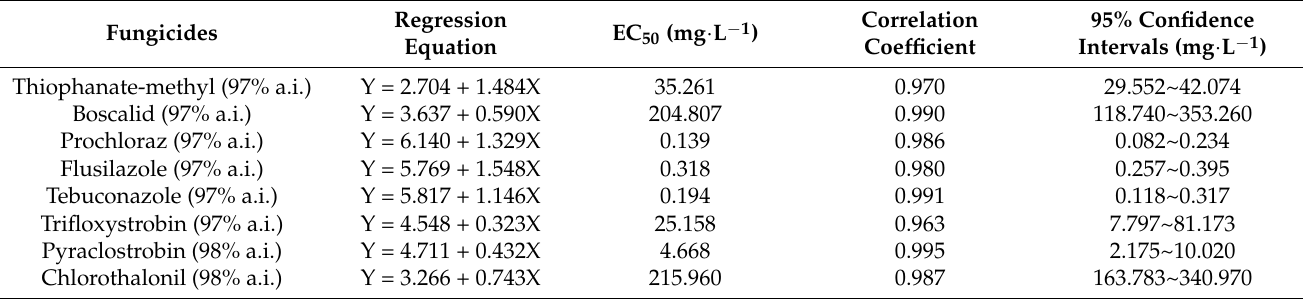
Table 4. Antifungal activities of fungicides against F. equiseti .